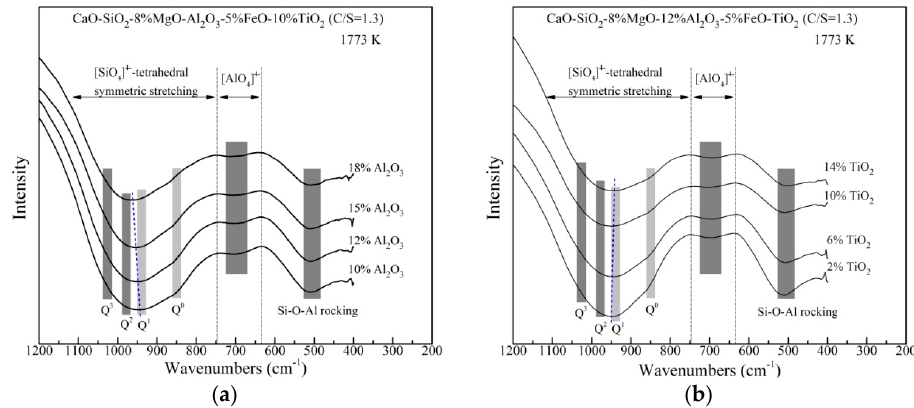
Figure 7. Spectra of the rapidly quenched slag samples with various ( a ) Al 2 O 3 content and ( b ) TiO 2 content. The slag structural units with changing Al 2 O 3 and TiO 2 content are further studied by Raman